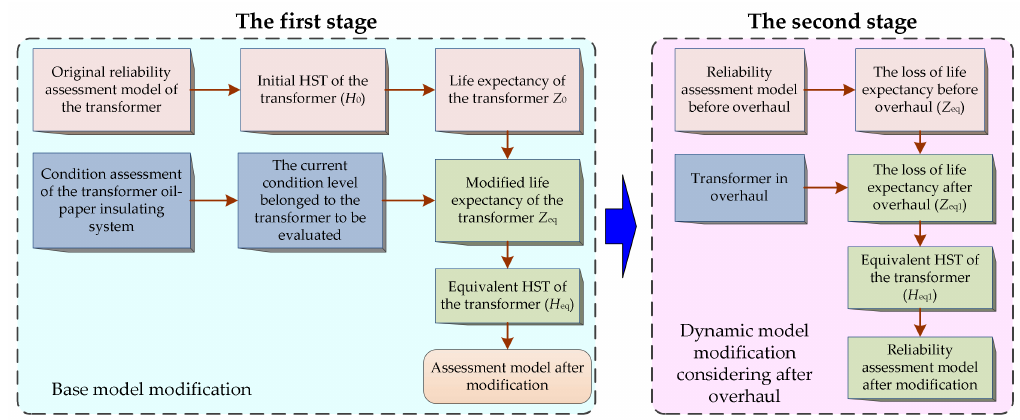
Figure 7. The dynamic modification process of the model developed by the author in